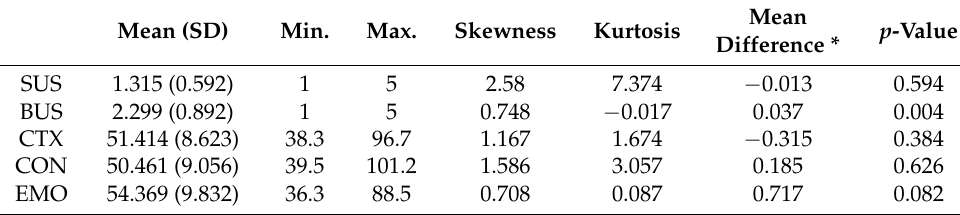
Table 1. Studied variables descriptives and mean differences according to vulnerability